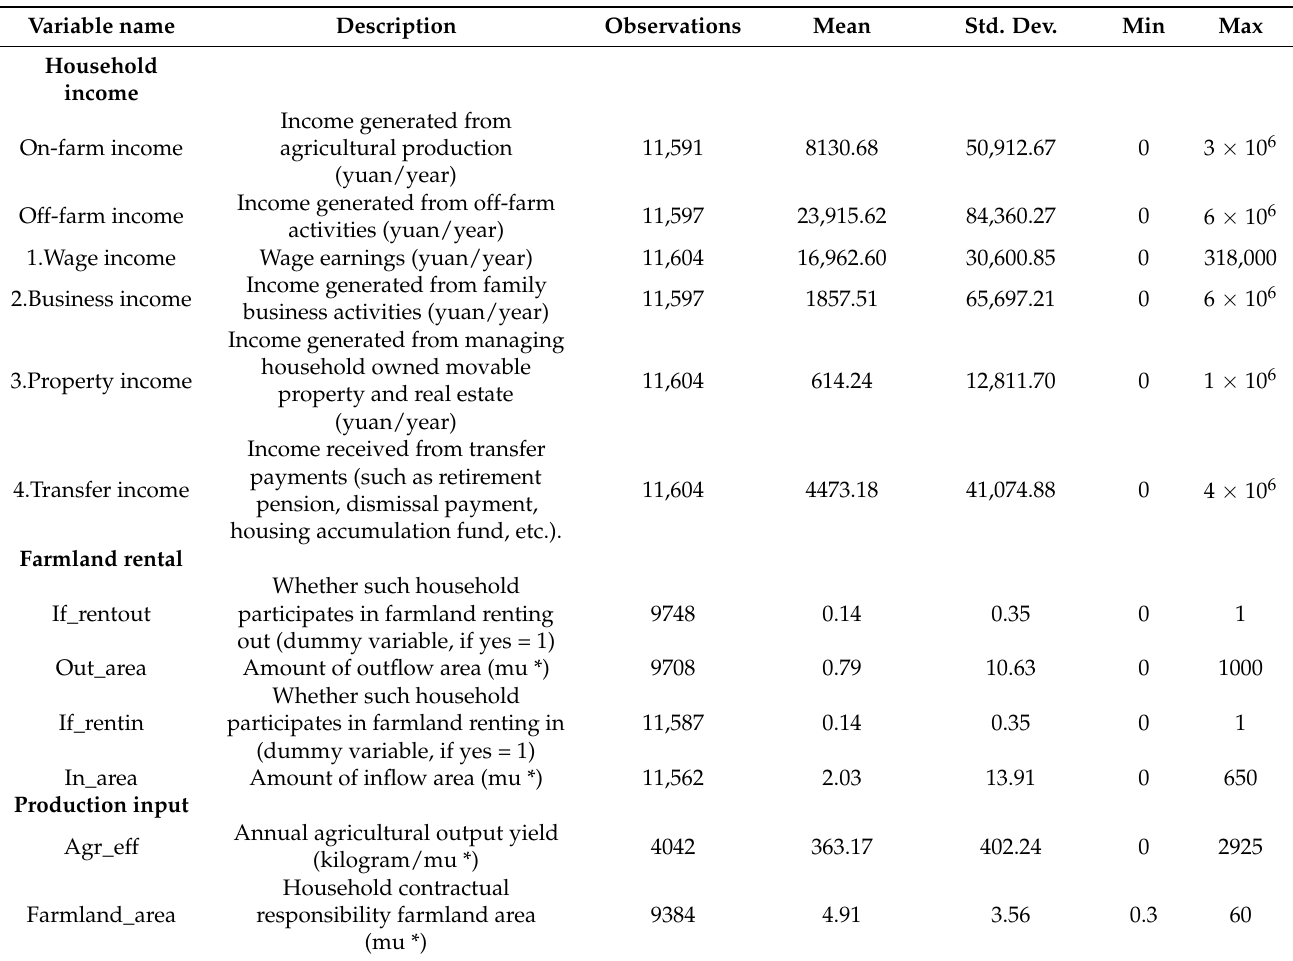
Table 1. Description and descriptive summary of the key